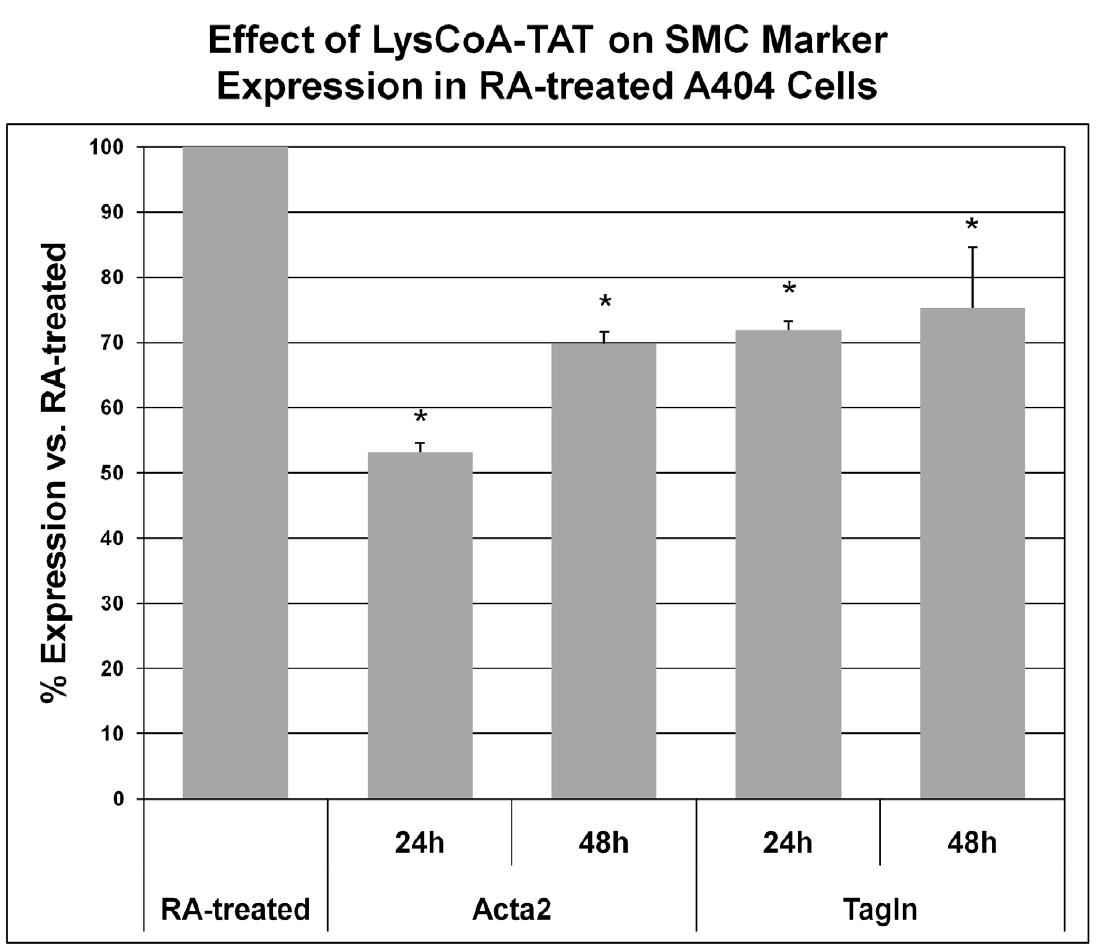
Figure 8. p300 HAT inhibition and A404 SMC differentiation markers. A404 cells were treated for 24 or 48 hours with retinoic acid (RA) 6 20 m M Lys-CoA-TAT. Shown are qRT-PCR expression values for Acta2 and Tagln, calculated as a percent of the RA-induced marker level for that time point. An RA-treatment bar is shown for comparison. * = significantly (p , 0.05) different from cells treated with RA alone.